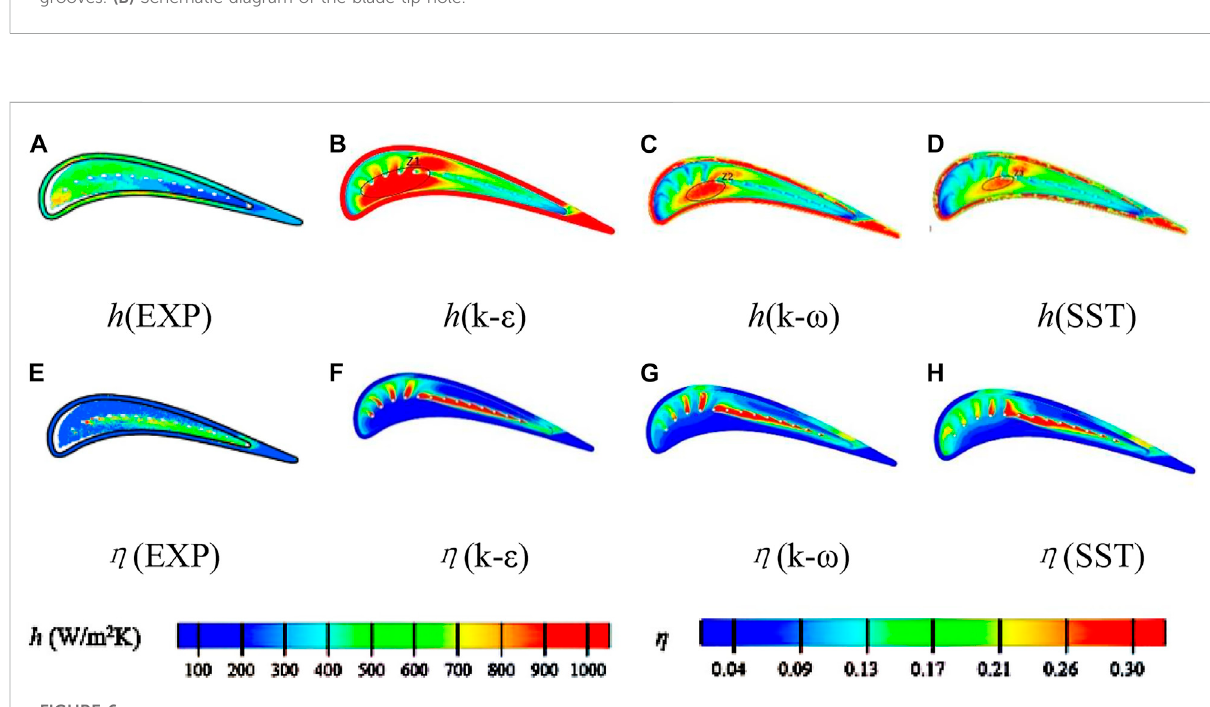
FIGURE 5 Grooved tip for veri fi cation of heat transfer characteristics (Nyland T W, Englund D R, Anderson R C,1971). (A) Tip grid with air conditioning grooves. (B) Schematic diagram of the blade tip hole.